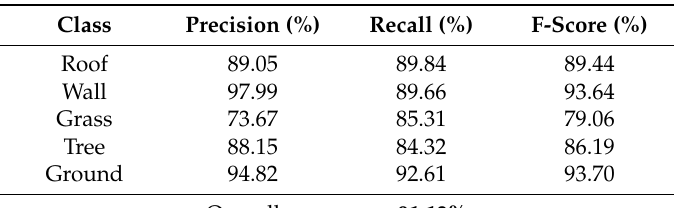
Table 3. Quantitative classification results of point clouds in